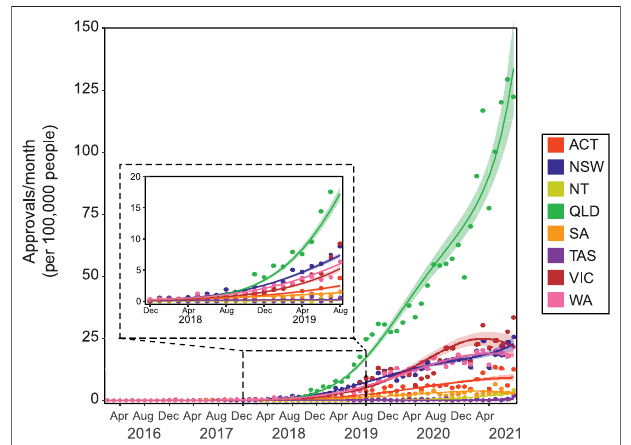
FIGURE 6 | SAS-B approvals across states and territories. The number of SAS-B approvals per month across states and territories represented as per 100,000 persons. Approvals from the Northern Territory (NT) followed a Poisson 1st degree polynomial curve (R 2 = 0.772). Approvals from Australian Capital Territory (ACT) and Western Australia (WA) followed Negative binomial, 2nd degree polynomial curves (R 2 = 0.926 and 0.986, and Δ m = 24.998, and 1,525.398, respectively). Approvals Victoria (VIC) followed aNegativebinomial,3rddegreepolynomialcurves(R 2 =0.934, Δ m=11.759). Approvals New South Wales (NSW), Queensland (QLD) and South Australia (SA) followed Negative binomial, 4th degree polynomial curves (R 2 = 0.982, 0.986, and 0.926, and Δ m = 6.783, 73.955, and 4.143, respectively). Approvals from Tasmania (TAS) moderately followed a Negative binomial, 3rd